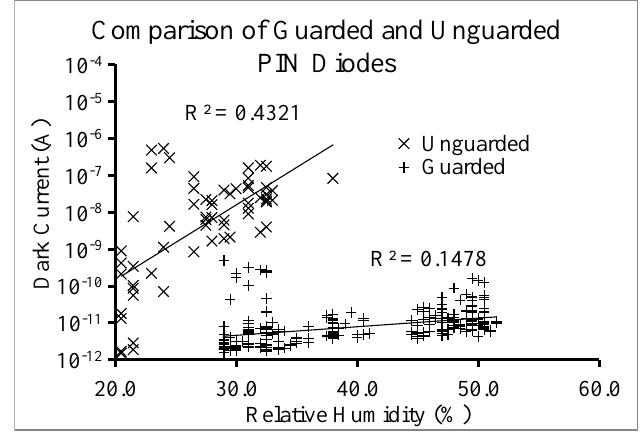
Figure 7. Top-down drawing comparing an unguarded PIN diode with only N and P terminals ( Left ); and guarded PIN diode structure with added guard ring (G) in addition to the N and P terminals ( Right ).